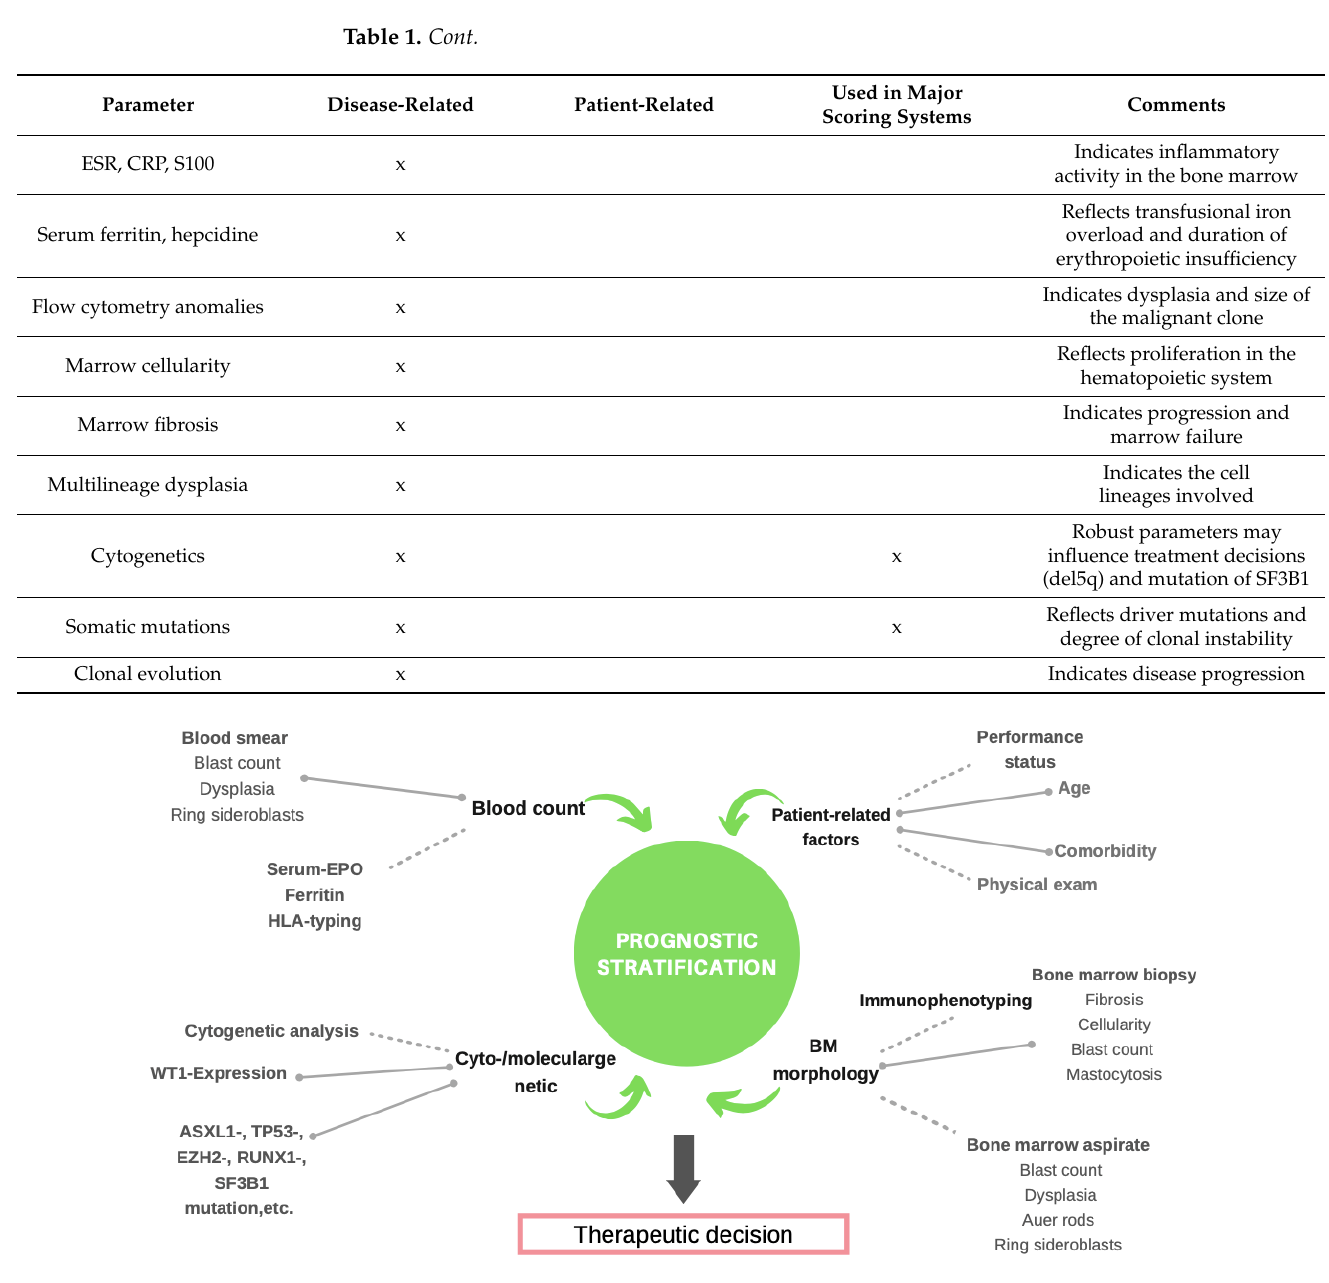
Figure 1. Clinical, morphological, cytogenetical, and molecular features in prognostic stratification of MDS patients.